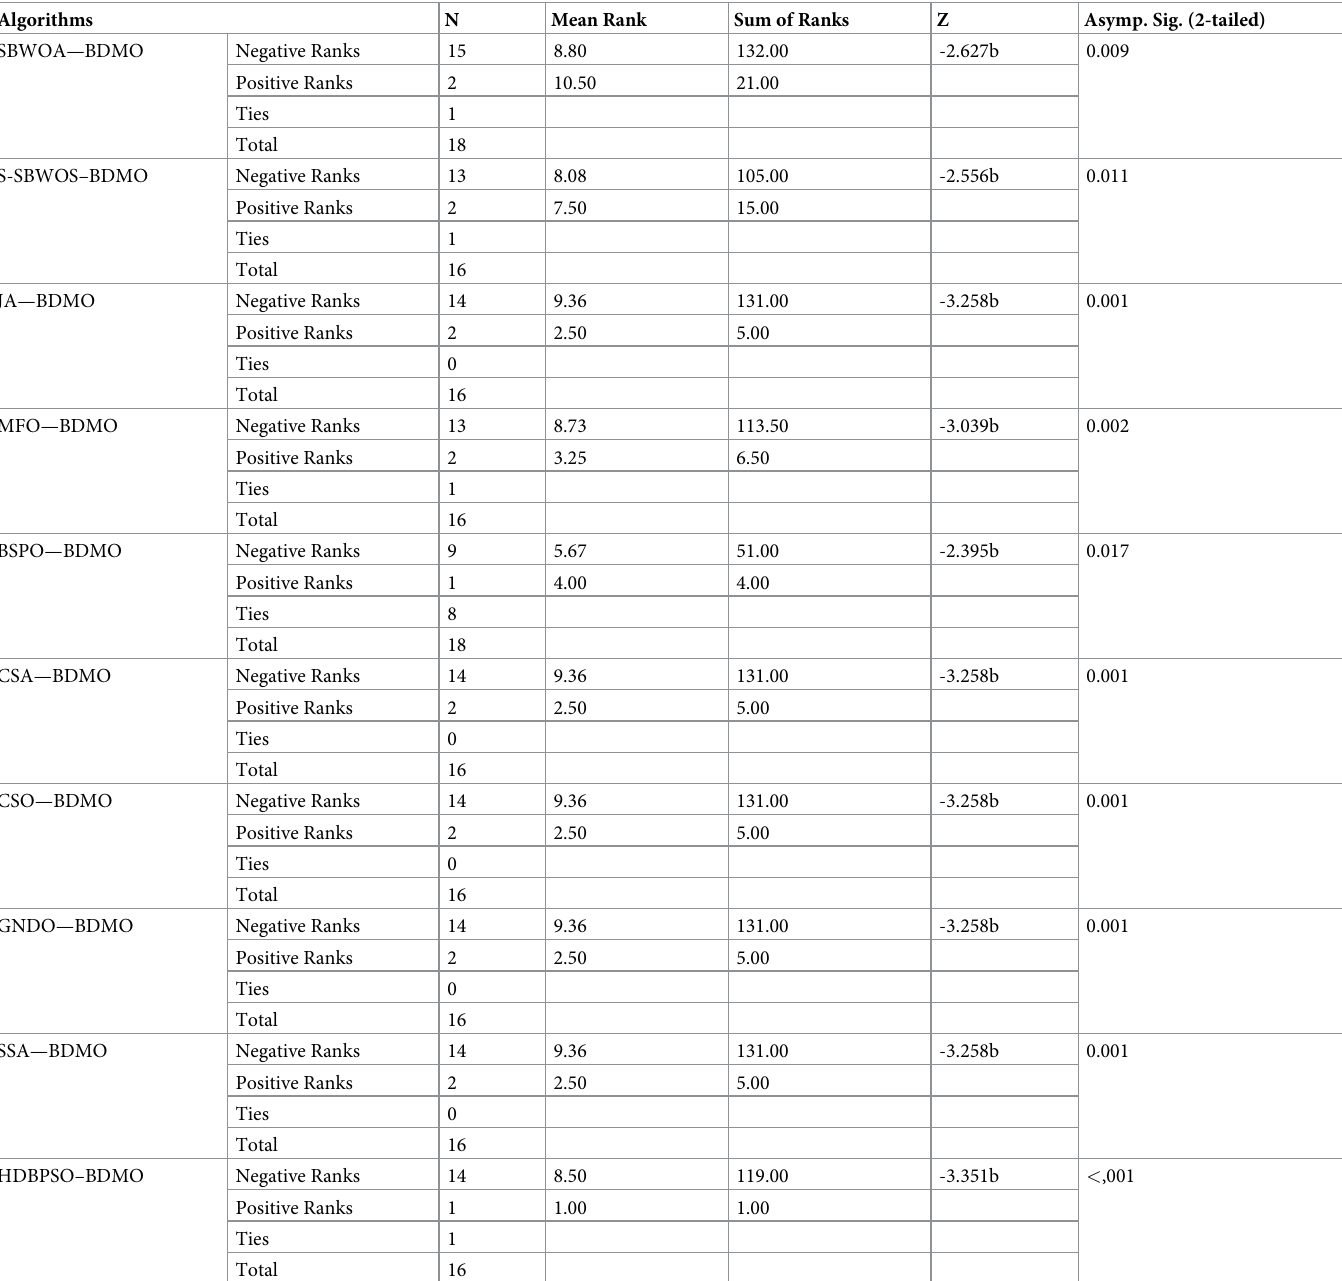
Table 8. Results of Wilcoxon sign test on validation